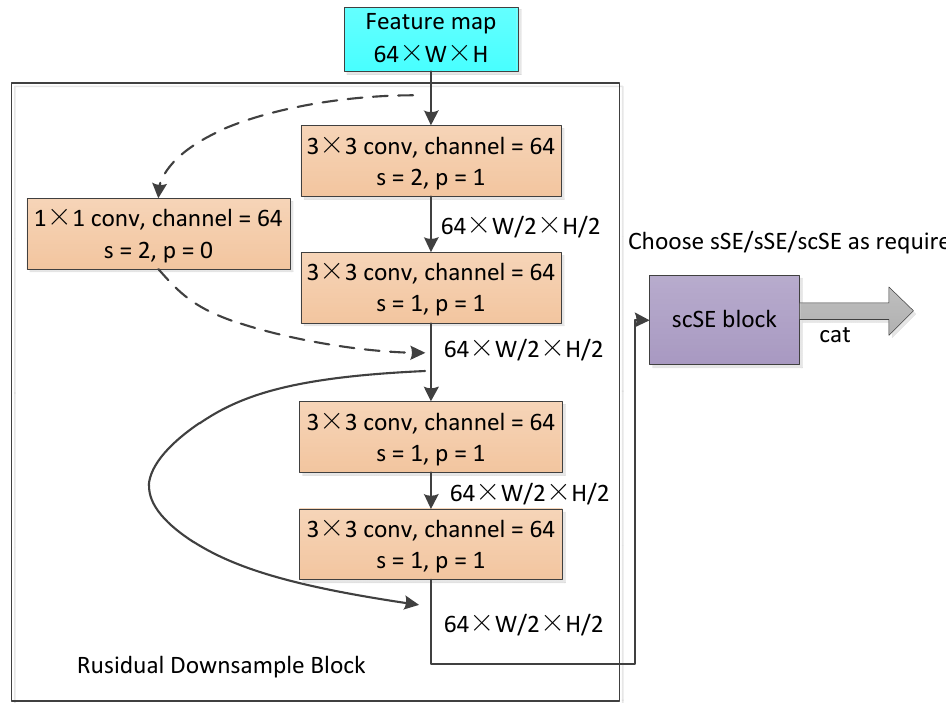
Figure 2. The details of the first residual downsample block and its subsequent links. The other three residual blocks are similar, except that the number of channels and the size of the feature map are different.